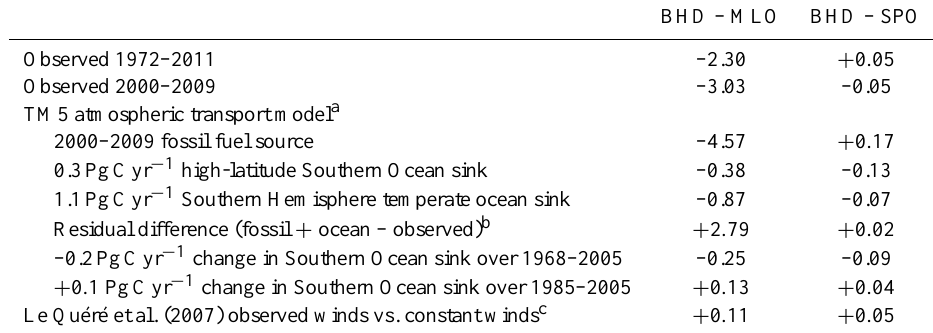
Table 1. Observed and modeled intersite CO 2 differences